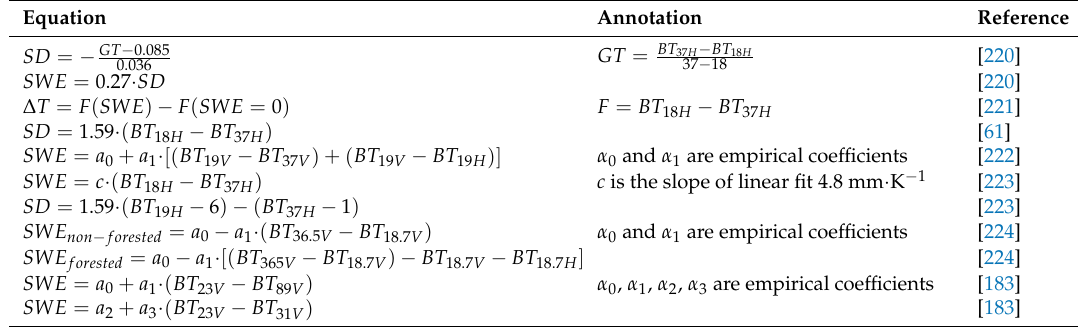
Table 2. Empirical equations for Snow Water Equivalent (SWE) and Snow Depth (SD)